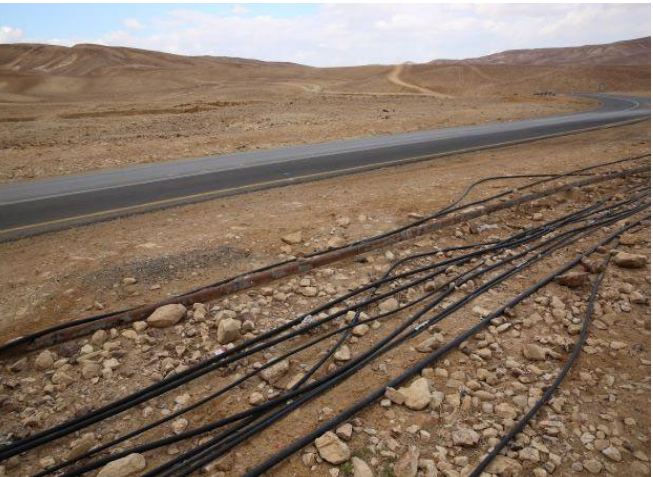
Figure 6. An unauthorized network of self-laid, sun-beaten black agricultural PVC irrigation pipes in Al Baqi’a valley, 2020. The pipes wind their way for miles, bringing precious water from the official pipeline to the isolated settlements, since the Bedouin residents have been denied access to the formal water pipeline of the state of Israel. Photographed by Dan Farberoff. Image courtesy of the artist.